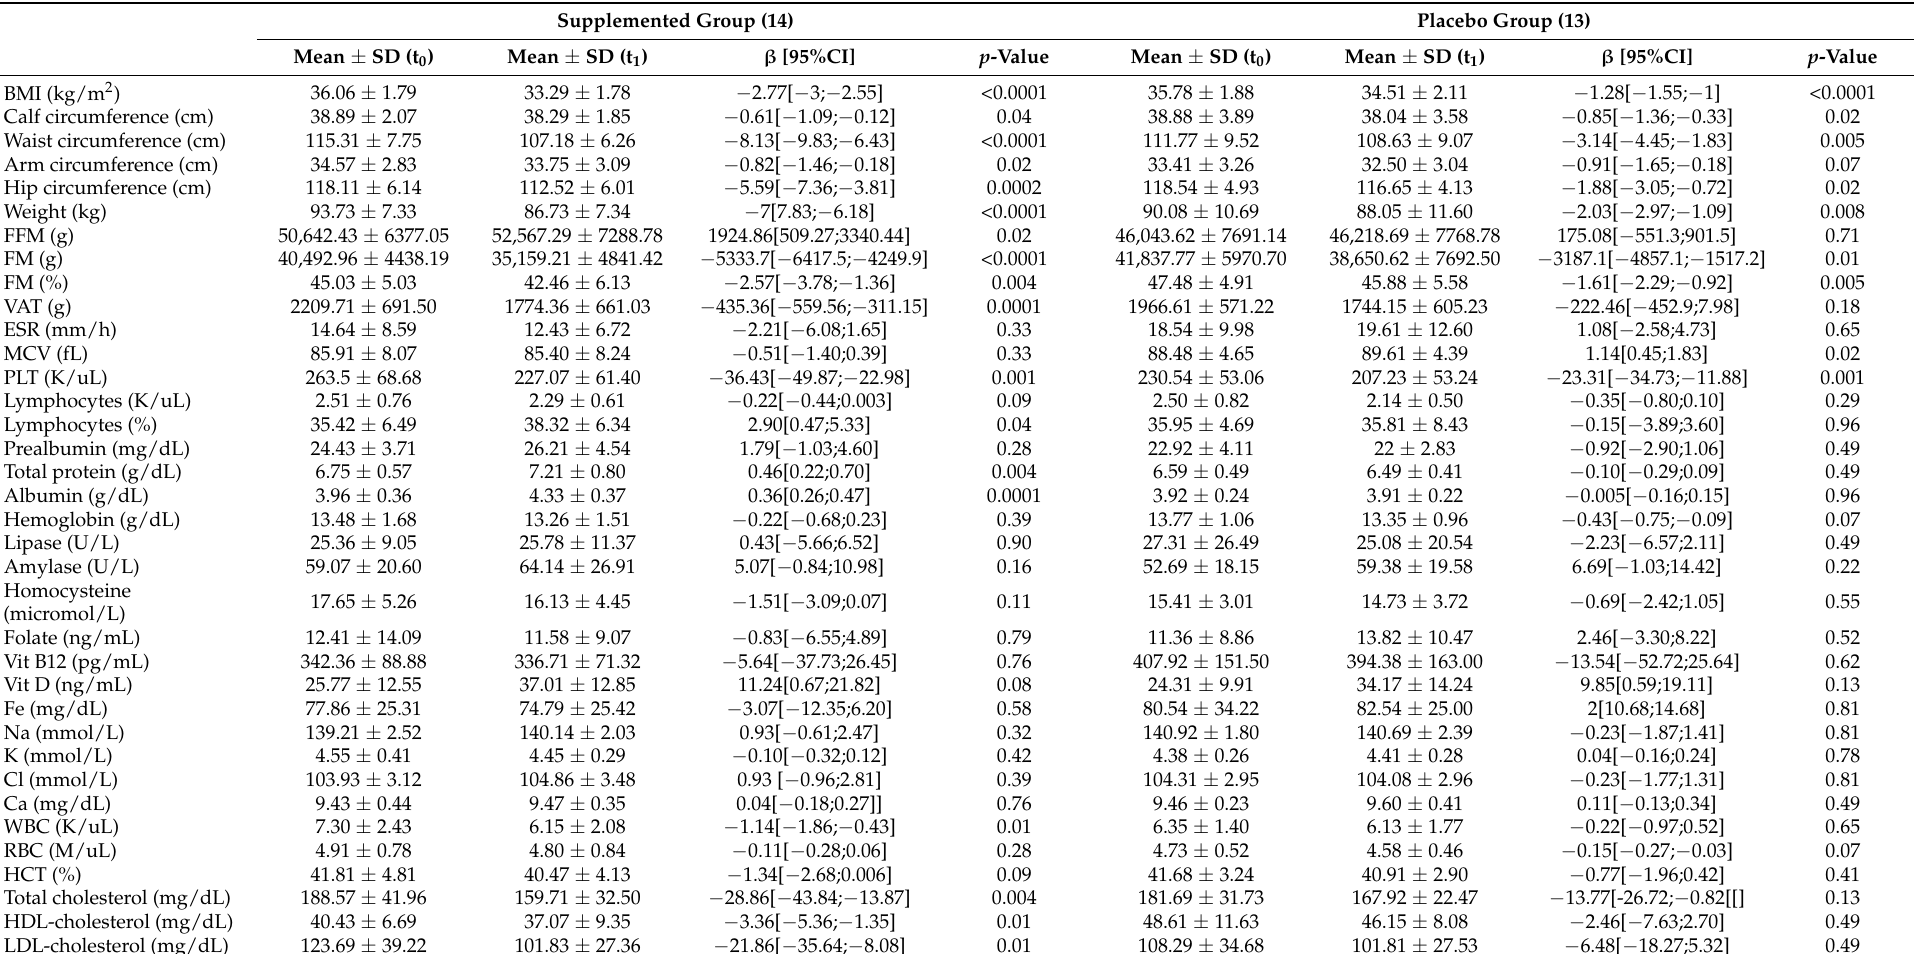
Table 3. Within-group differences for anthropometric, body composition, and biochemical measurements for the supplemented and placebo groups. The estimate of the effect β , 95% confidence interval (CI), and the adjusted p -value of the null hypothesis of a null effect are